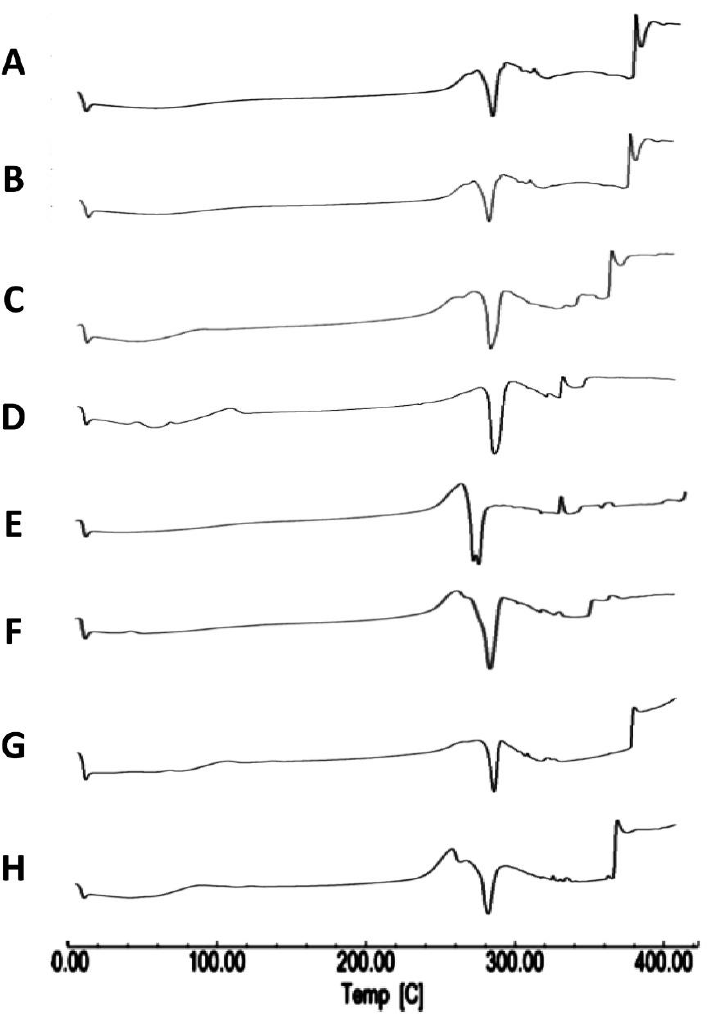
Figure 2. DSC scans of different TAA formulations. ( A ) Micronized TAA raw material unprocessed and ( B ) 1%, ( C ) 1.5%, ( D ) 2%, ( E ) 2.5%, and ( F ) 3% ( w / v ) TAA systems spray-dried from 90% ( v / v ) ethanol, ( G ) 1% TAA system spray-dried from 70% ( v / v ) ethanol, and ( H ) 1% TAA system spray-dried from 80% ( v / v ) ethanol.